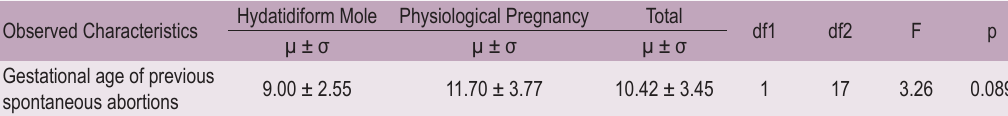
TABLE 5. Difference in the average gestational age of spontaneous abortions in the groups Observed Characteristics